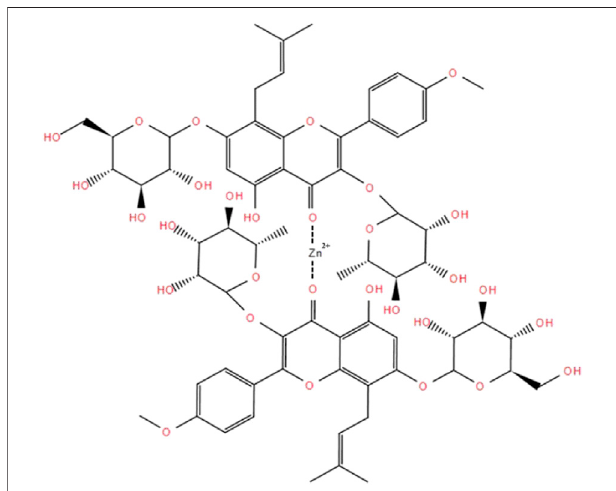
FIGURE 13 | Molecular structure of